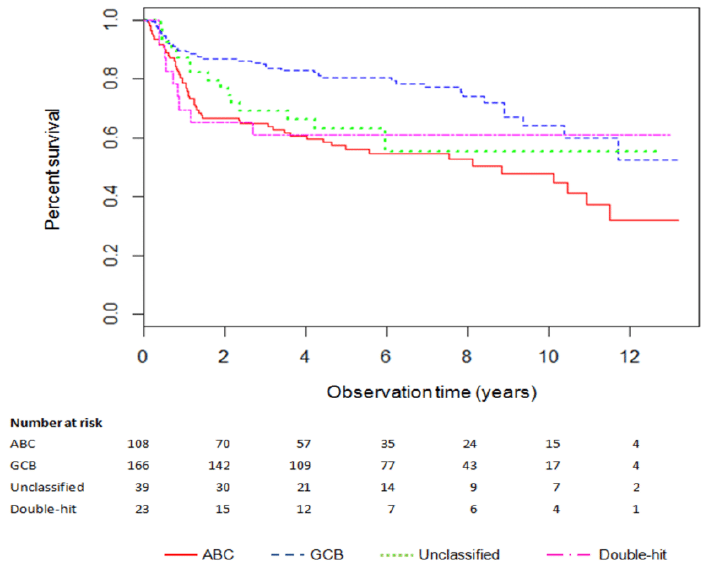
Figure 2. Kaplan-Meier plot of overall DLBCL survival by cell-of-origin subtype. Figure 2 legend: